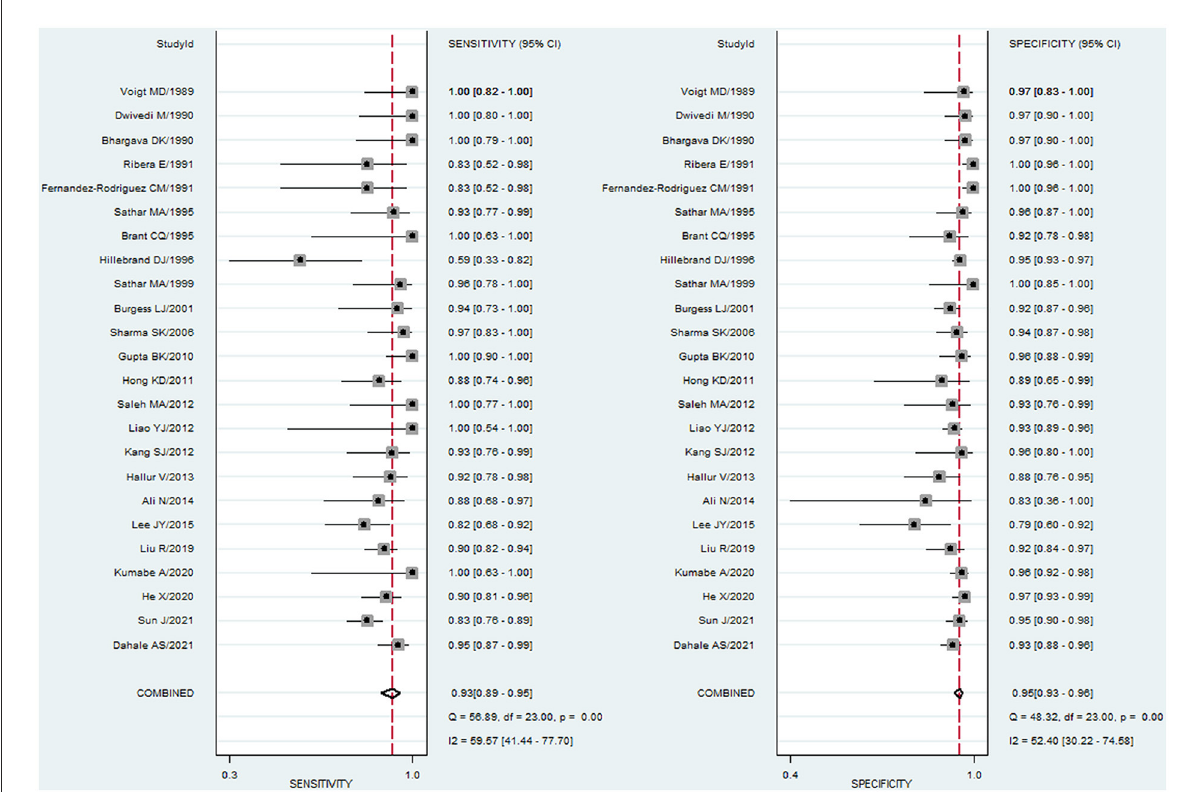
FIGURE3 Paired forest plots of pooled sensitivity and specificity of ADA for the diagnosis of abdominal TB. Sensitivity and specificity in each study were represented by squares, and 95% confidence intervals were represented by horizontal bars.